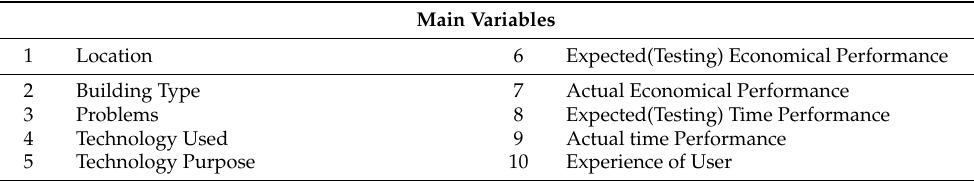
Table 1. Main variables.